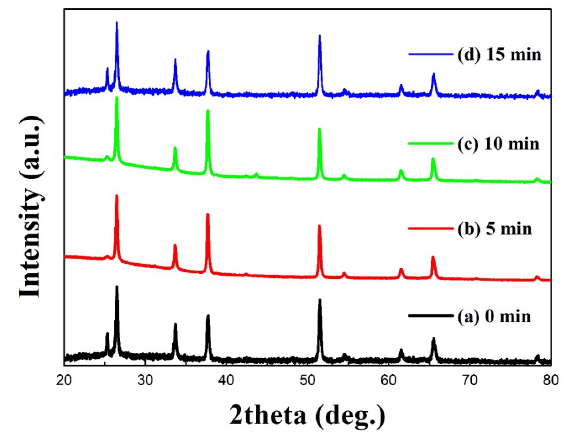
Figure 3. XRD patterns of the FTO substrate before and after the CMP process.